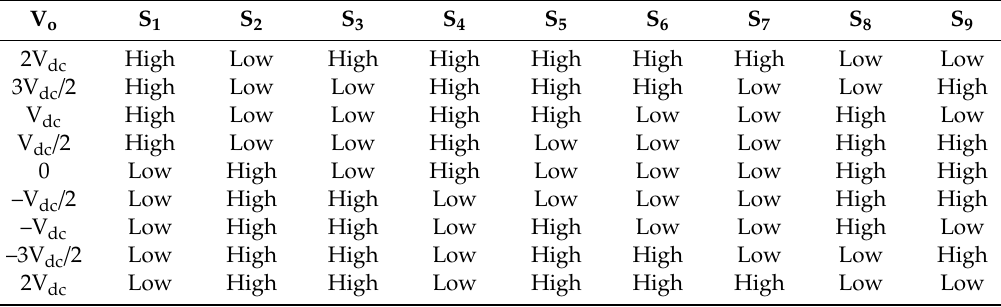
Table 1. Switching combinations for multilevel inverter (MLI).